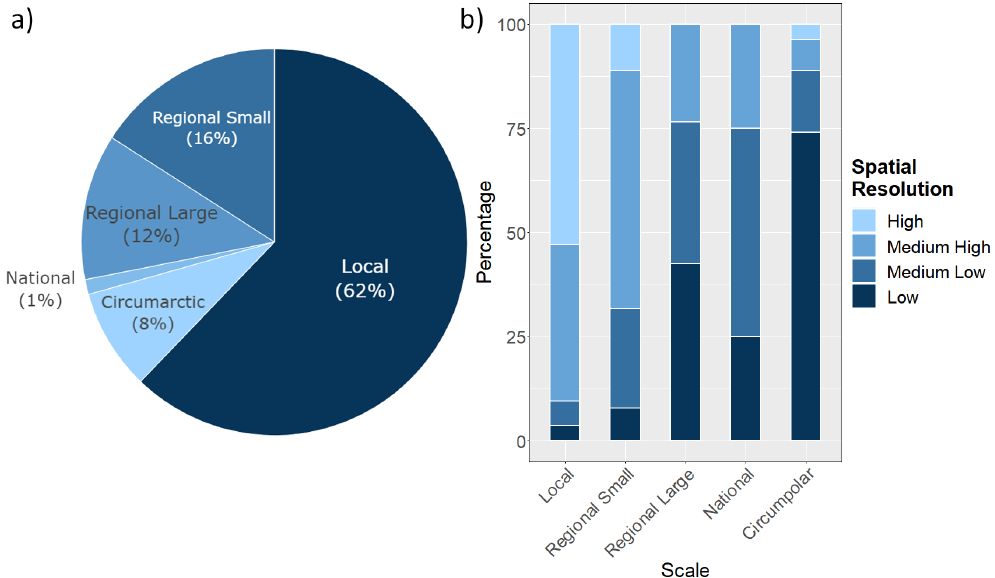
Figure 11. ( a ) Distribution of investigated spatial scales across the reviewed articles. The scales are categorized as local (<10,000 km 2 ), regional small (10,000–250,000 km 2 ), regional large (>250,000 km 2 ), national or circum-Arctic. ( b ) Applied spatial resolutions within each scale. Spatial resolutions are categorized as high (<10 m), medium high (10–100 m), medium low (100–1000 m) or low (>1000